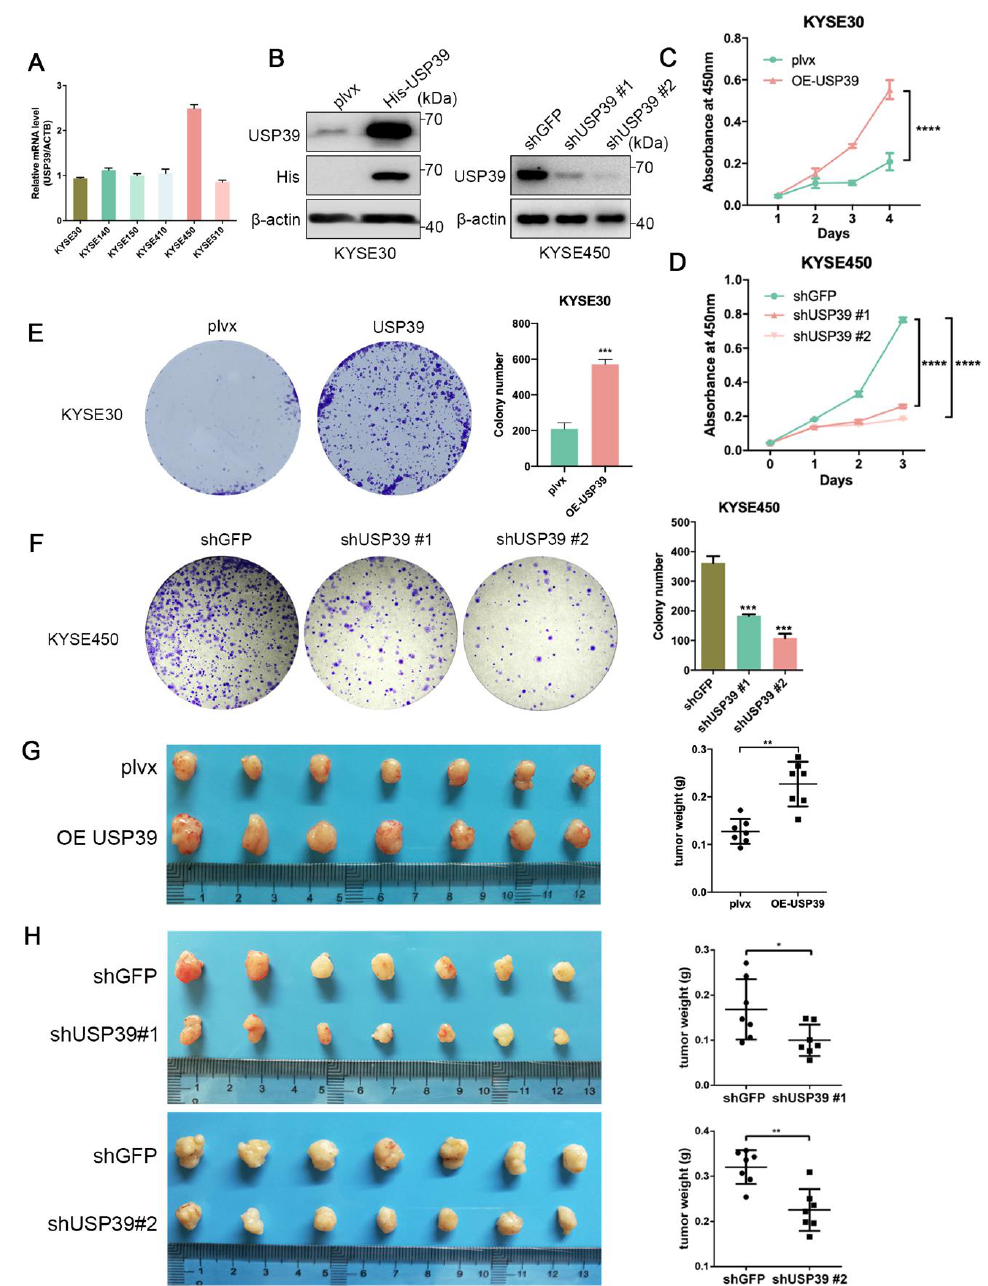
Figure 2. USP39 promotes the proliferation of ESCC cells in vivo and in vitro . ( A ) Quantitative real-time PCR detection of USP39 expression in ESCC cell lines. ( B ) Overexpression and knockdown efficiency of USP39 in KYSE30 and KYSE450 was determined by Western blot. ( C , D ) Cell proliferation detected by the CCK-8 assay after USP39 overexpression ( C ) or knockdown ( D ) in KYSE30 cells and KYSE450 cells, respectively. ( E , F ) Cell proliferation detected by colony formation assays after USP39 overexpression ( E ) or knockdown ( F ) in KYSE30 and KYSE450 cells, respectively. n = 3 per group. ( G , H ) Images of xenograft tumors, tumor weight in mice subcutaneously injected with ESCC cells overexpression ( G ) or knockdown ( H ) of USP39. n = 7 mice per group. Data in C-H represent mean ± SD. Data were analyzed by two-way ANOVA ( C , D ) with Bonferroni correction or unpaired two-tailed Student’s t -test ( E – H ). ns = no significant, * p < 0.05, ** p < 0.01, *** p < 0.001, **** p <